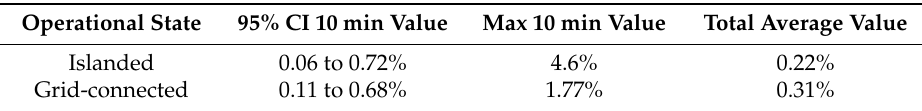
Figure 8. CDF for the 10 min voltage unbalance values in the nanogrid during islanded and grid-connected operation. Table 3. 95% confidence interval, the maximum 10 min value and total average value for all three phases in islanded and grid-connected